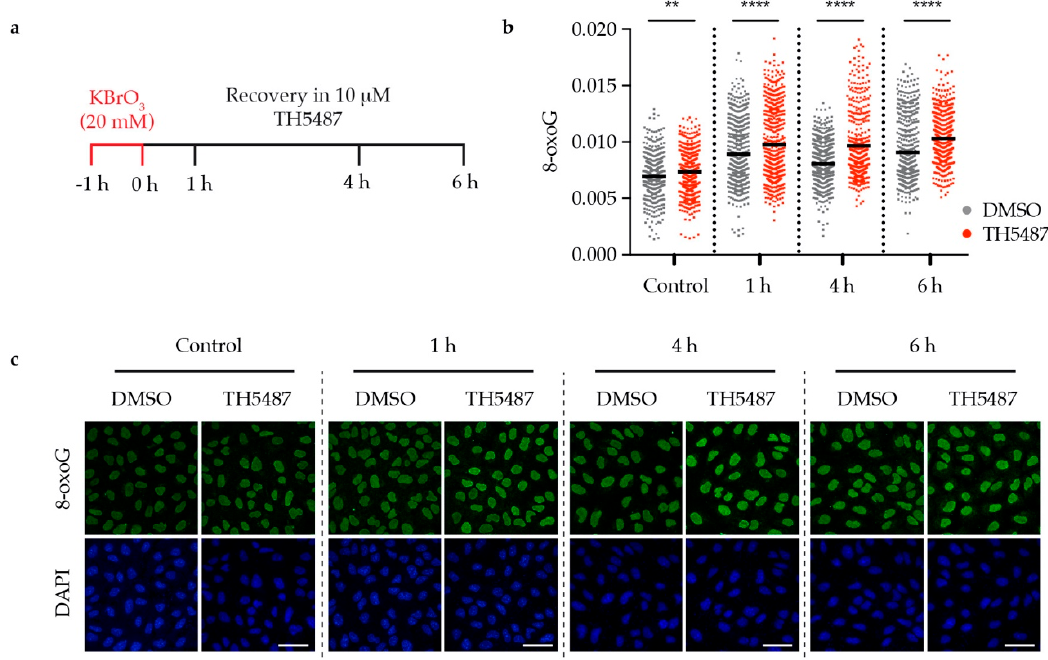
Figure 1. OGG1 inhibition with TH5487 results in accumulation of genomic 8-oxoG base lesions. ( a ) Scheme of TH5487 treatment to study the repair kinetics of genomic 8-oxoG. ( b ) Fluorescence signal intensity of 8-oxoG at the indicated time points. U2OS cells were pre-challenged with 20 mM KBrO 3 for 1 h, then allowed to recover in a medium containing either 0.1% DMSO or 10 μ M TH5487 for the indicated time points. Scatterplot shows data of at least 500 cells for each treatment condition with the mean from three independent experiments. Statistical significance was determined using an unpaired two-sided t -test (** P < 0.01, **** P < 0.0001). ( c ) Representative confocal images of U2OS cells showing accumulation of genomic 8-oxoG lesions. Scale bar: 50 μ m.